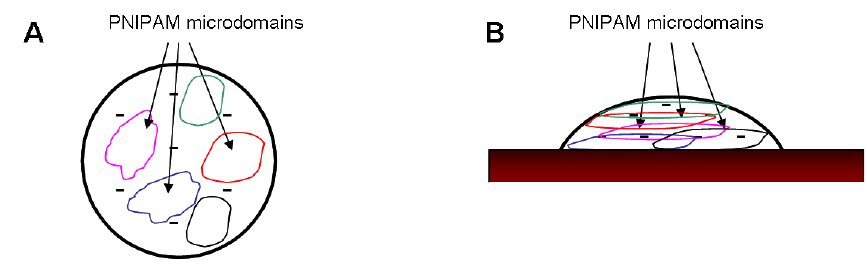
Figure 5. A : Particles in the bulk: the morphology suggests a lower charge density and gives a possibility for a PNIPAM collapse. The coloured areas correspond to undisturbed PNIPAM microdomains, which overlap and are riddled with co-monomers after adsorption, B : Adsorbed particles: the functional groups exhibit a higher charge density resulting in hindered or disappeared PNIPAM collapse.